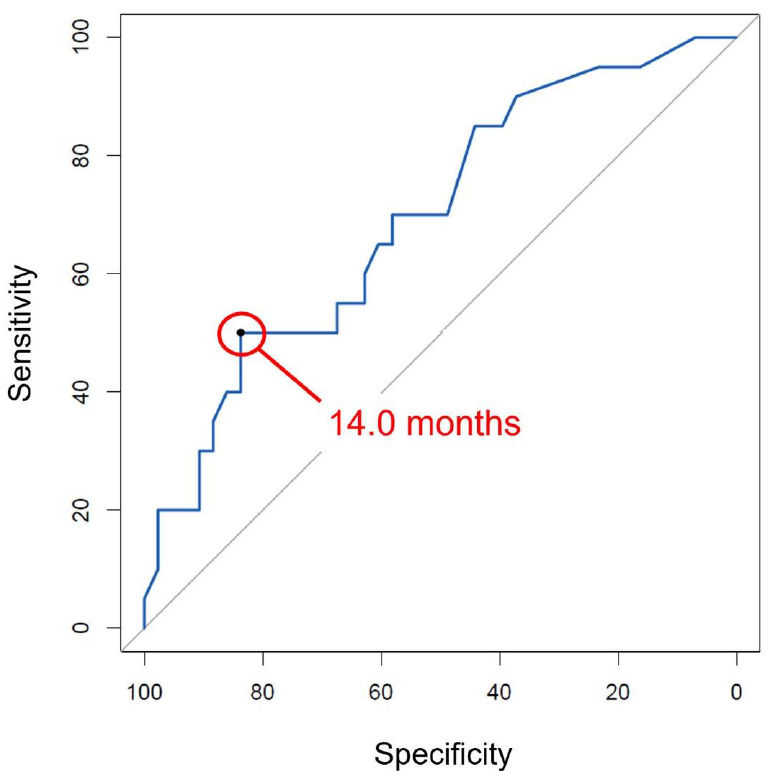
Figure 2. Receiver operating characteristic curve for unstable flap showed that the cutoff point of symptom duration was 14.0 months, with the area under curve being 0.70 (sensitivity, 50.0%; specificity, 83.7%).